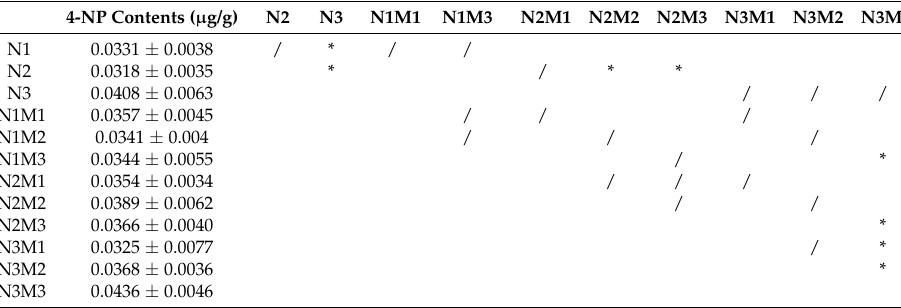
Table 5. Statistical analysis of 4-NP contents in liver at Day